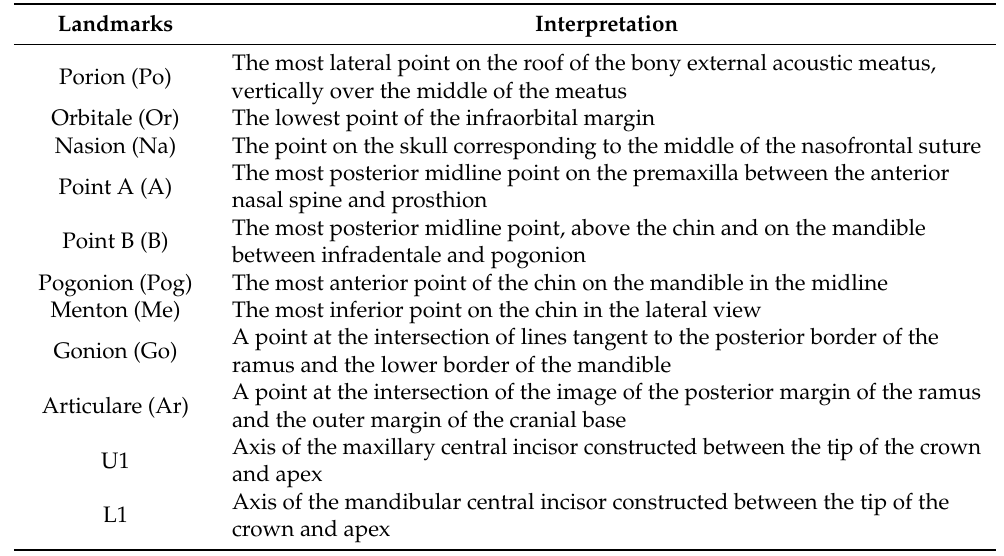
Table 1. Landmarks for the 3D analysis.